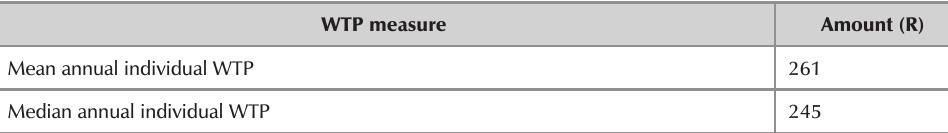
Mean and median annual individual WTP for the improvement of the trout habitat of the WTA-managed waters of the Rhodes